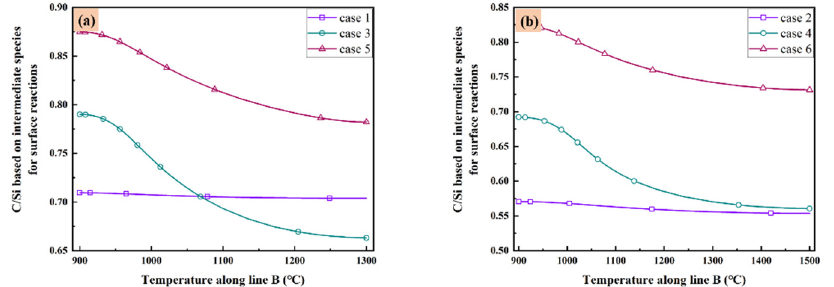
Figure 6. C/Si ratio based on intermediate species for surface reactions as the function of tempera- ture along line B: ( a ) case 1, case 3 and case 5; and ( b ) case 2, case 4 and case 6.